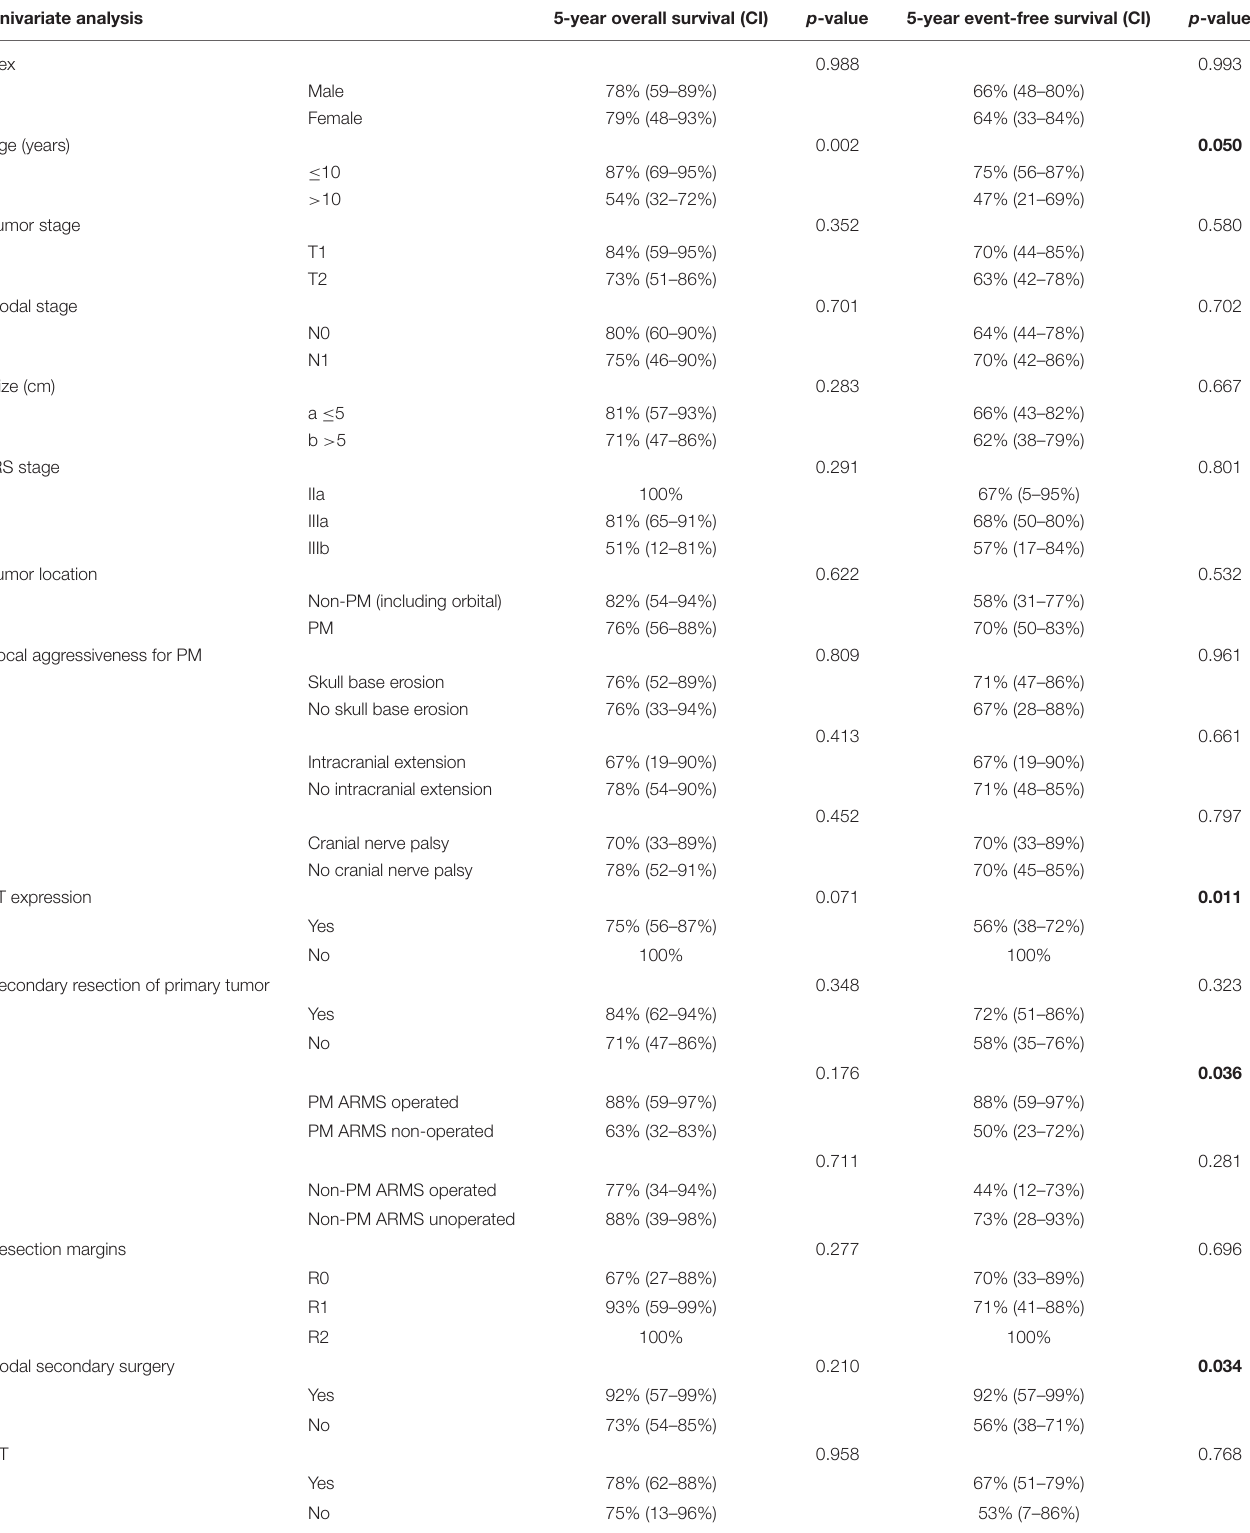
TABLE 5 | Univariate analysis of 5-year OS and EFS according to patients and tumors’ characteristics and treatment modalities for the 48 HN-ARMSs. Univariate